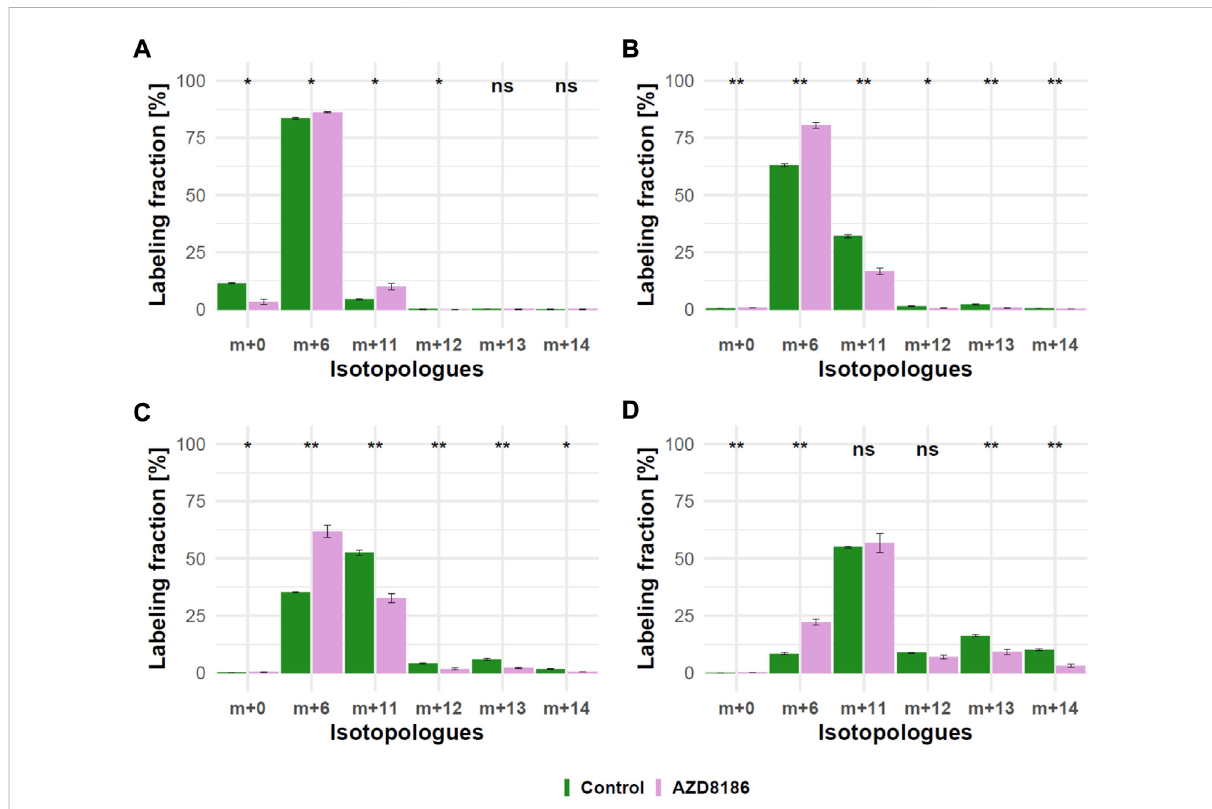
FIGURE 6 Time course of 13 C tracer incorporation in UDP-Glucose. MDA-MB-468 cells were cultivated in RPMI with [U- 13 C] glucose and treated with 0.5 µM AZD8186 (purple) or vehicle (green). Bar charts ±standard deviation (n = 3 technical replicates) showing the fractional enrichment of 13 C into UDP-Glucose at 1 h (A) , 3 h (B) , 6 h (C) and 24 h (D) sampling times. * p < 0.05; ** p < 0.01 (adjusted p -value; Welch ’ s t